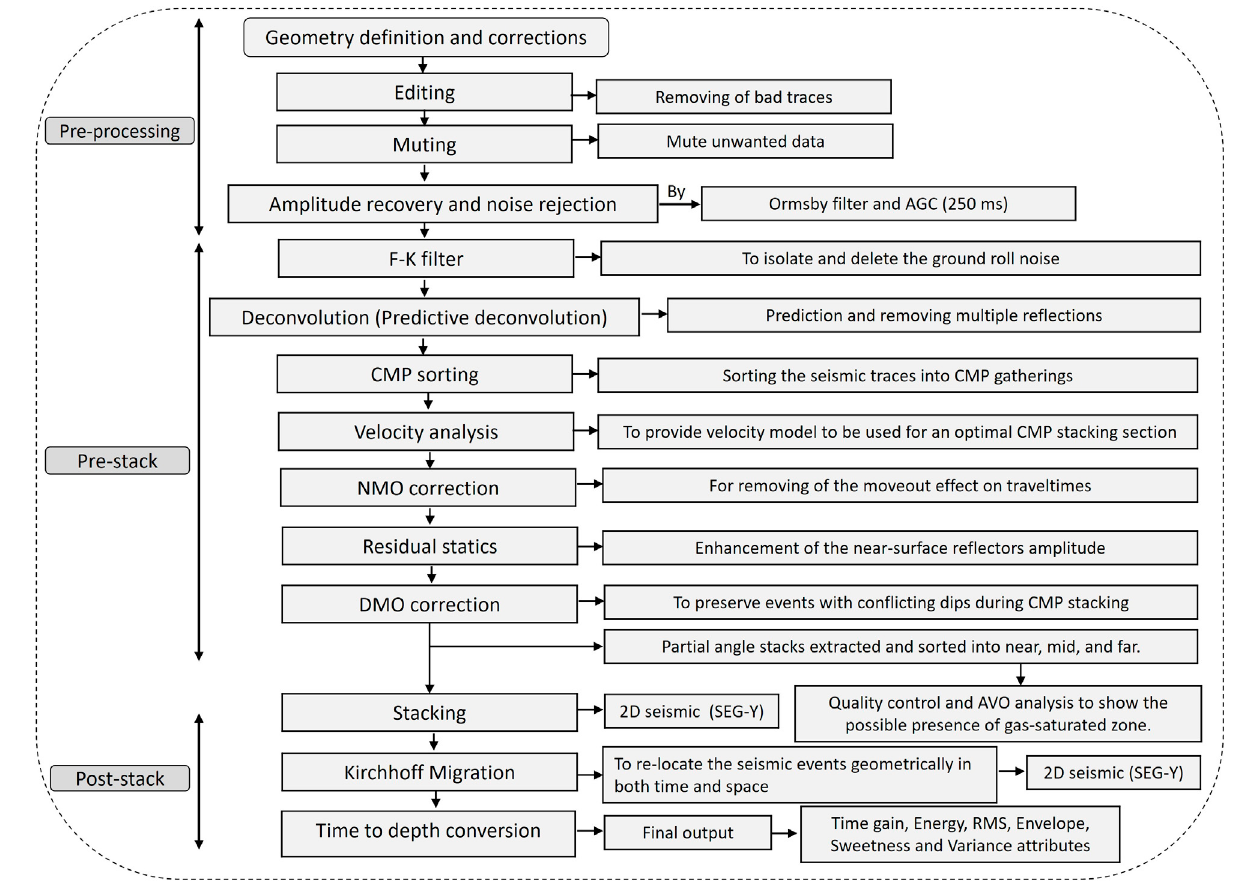
Frontiers in Earth Science |